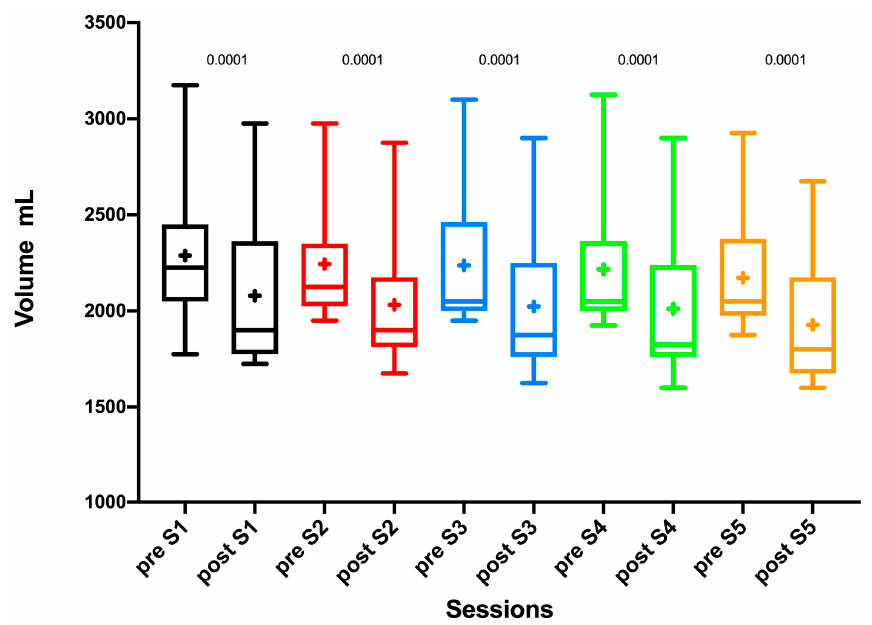
Figure 3. Box and whiskers of leg volume variation before (pre) and after (post) the five exercise sessions (S1, S2, S3, S4, S5). The symbol + indicates the mean. Table 3. Leg volume variation pre- and post-exercise of every single session.